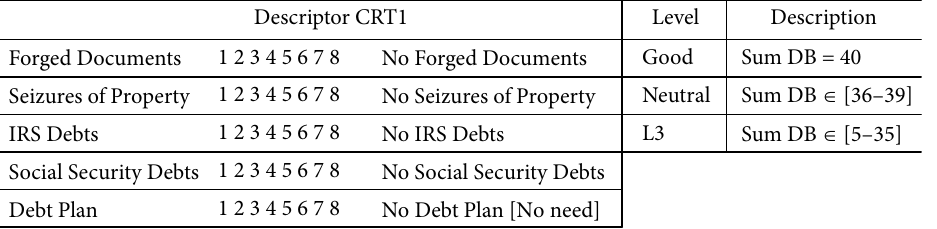
Table 2. Descriptor and impact levels for